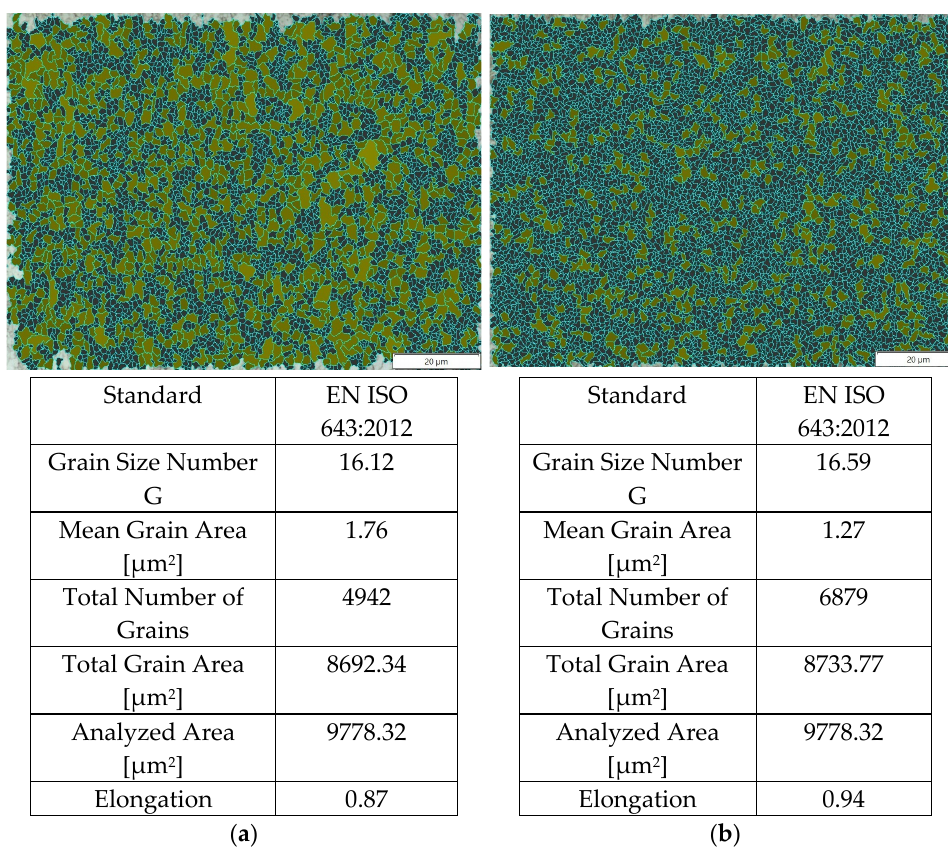
Figure 7. Measurement of grain size on the radius of the friction-welded joint with p f = 191 MPa: ( a ) HAZ, ( b ) friction weld.